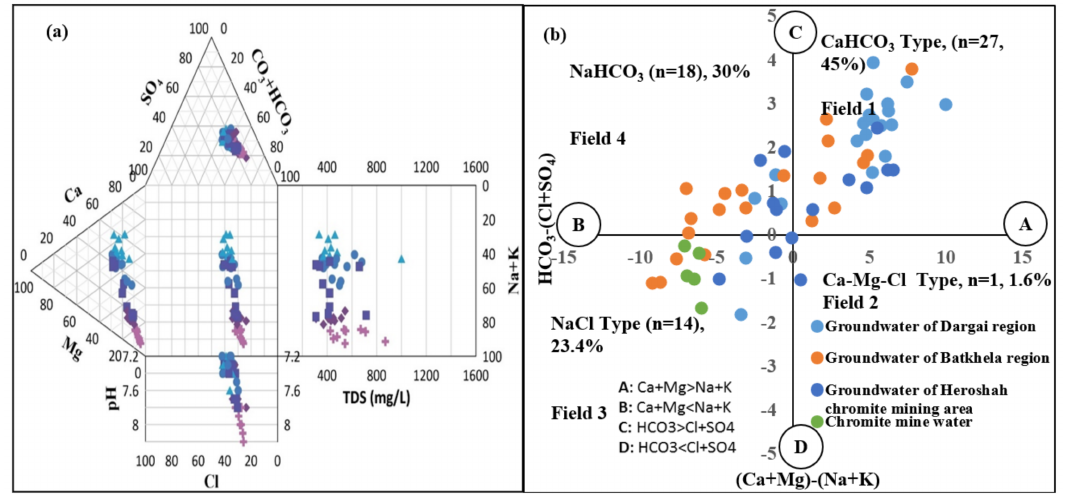
Figure 3. ( a ) represents the Durov plot compiled groundwater of mining with green circle, and non- mining water with blue circle, pH with square, and TDS with plus sign; and ( b ) reveals the Chadha diagram compiling mechanism responsible for groundwater type formations in the study